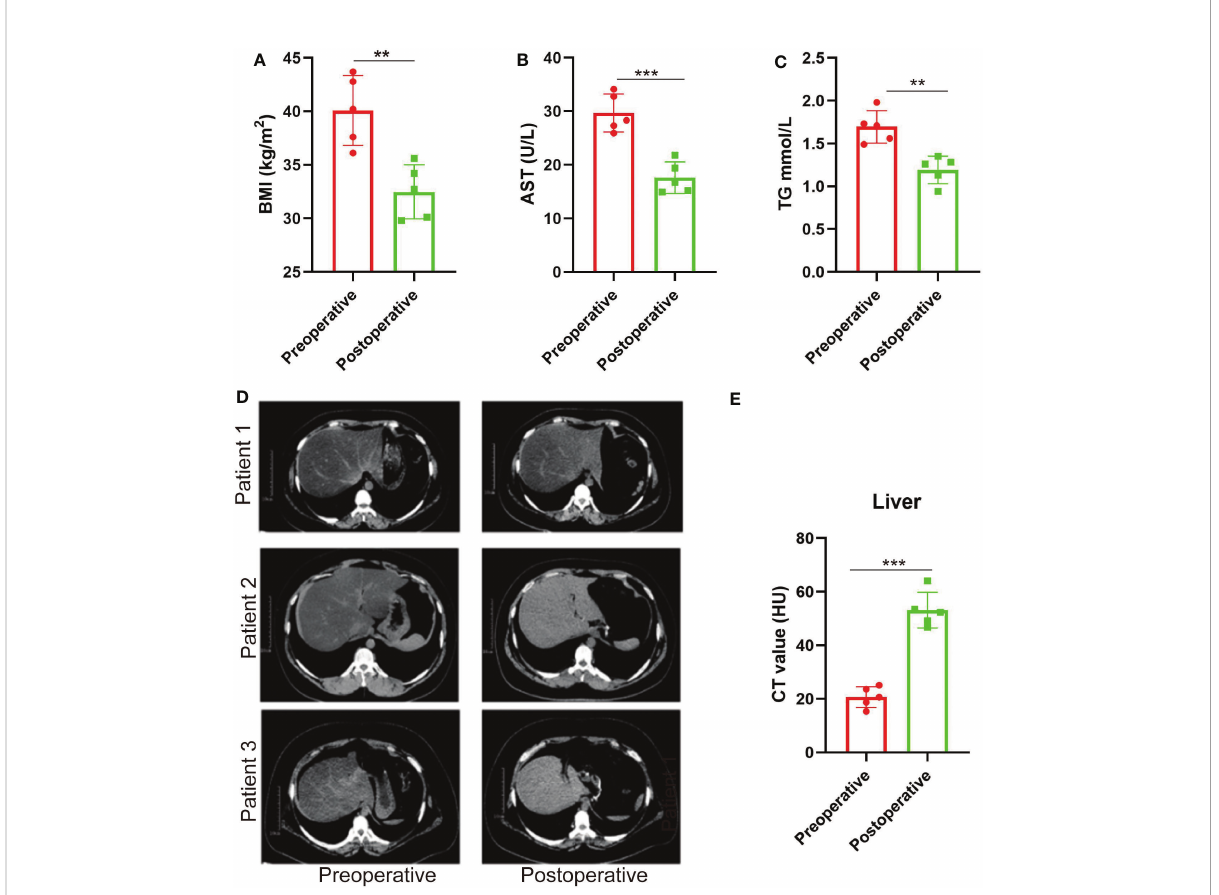
FIGURE 1 NAFLD is relieved after SG in patients with obesity. (A – C) BMI values, plasma AST, and TG before and 3 months after SG on patients with obesity. n = 5. (D) CT scan images of the liver in patients with obesity before and 3 months after SG surgery (three out of the fi ve patients). (E) CT values of the liver before and 3 months after SG surgery on patients with obesity. n = 5. Wilcoxon test was used to compare the data before and after surgery. Data are presented as mean ± SEM, ** p < 0.01, *** p <